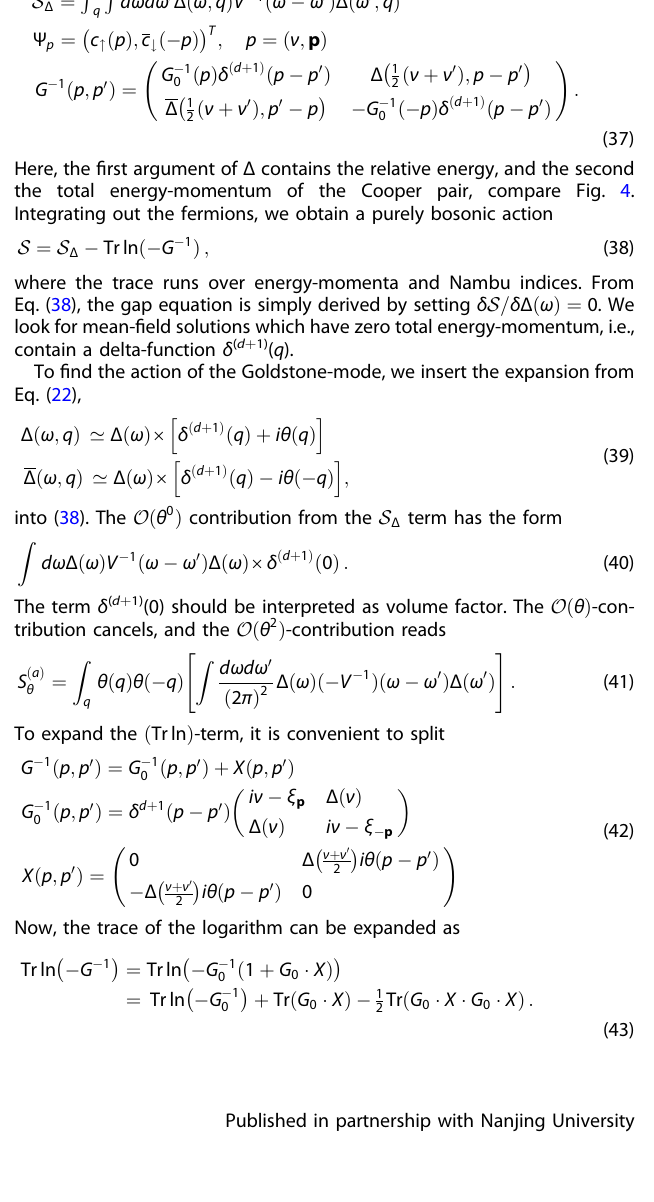
Fig. 6 Generalized super fl uid density. a n s ( q ) determined from Eqs. (35) and (36), b κ ( q ), obtained in the same way as n s ( q